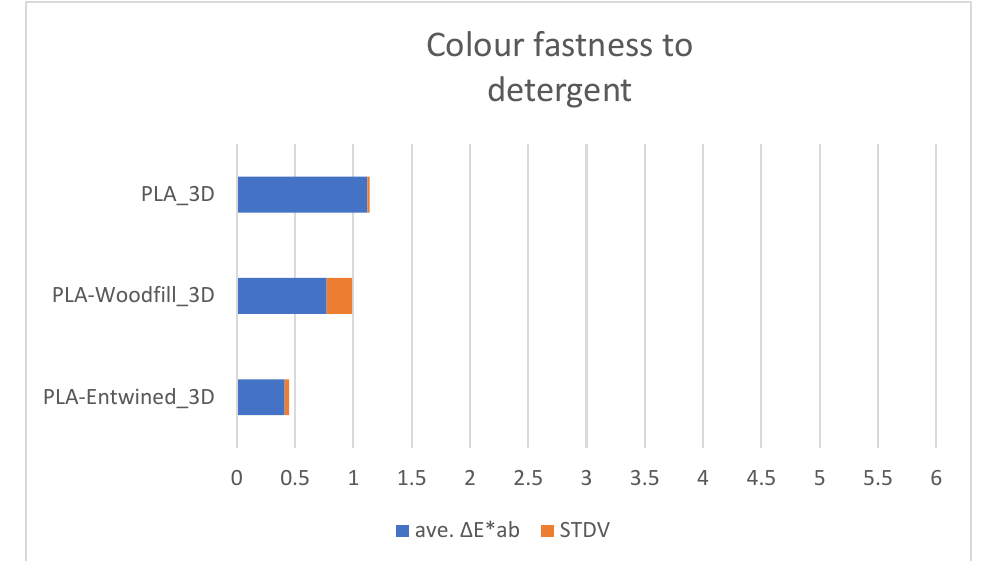
Figure 10. Colour fastness to detergent.